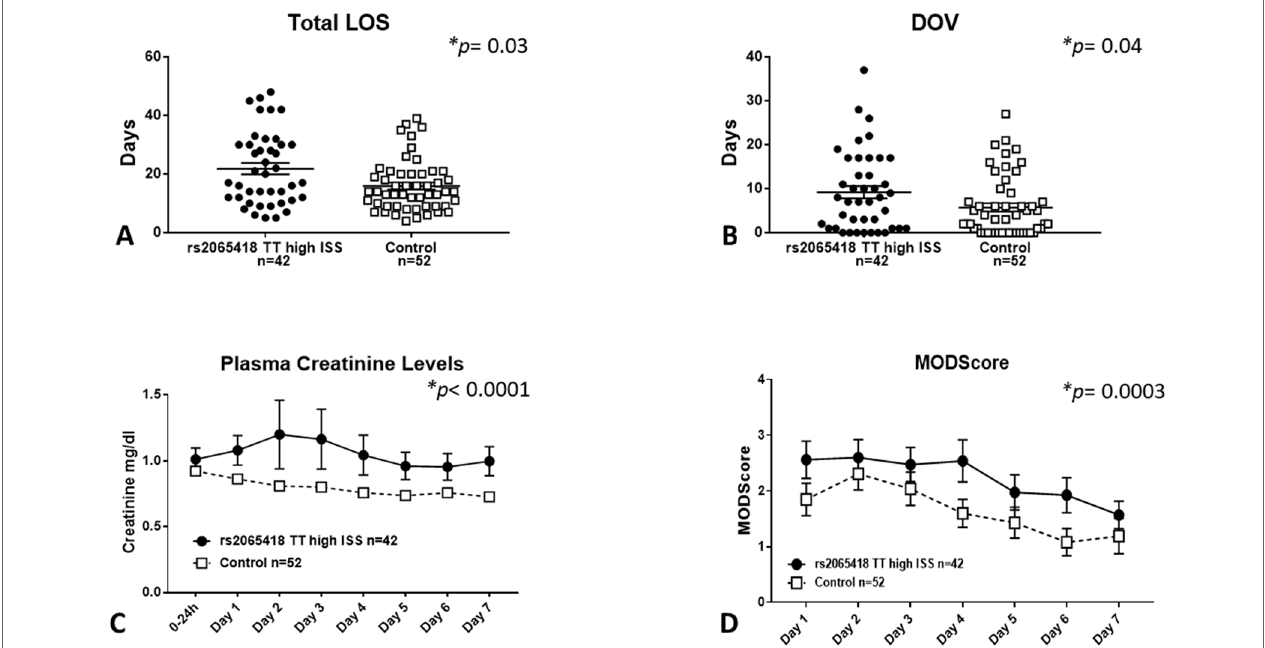
FIgUre 2 | Severely injured rs2065418 TT patients exhibit worse clinical outcomes vs. control. High-severity rs2065418 TT patients ( n = 42) and control rs2065418 TG/GG patients ( n = 52) were assessed for clinical outcomes as described in the Materials and Methods . High-ISS rs2065418 TT patients exhibited longer total LOS ( p = 0.03) (A) longer DOV ( p = 0.04) (B) elevated plasma creatinine levels ( p 0.0001) (c) , and higher Marshall MODScore over 7 days ( p = 0.0003) (D) compared to the control group of high-ISS rs2065418 TG/GG patients. Total LOS and DOV were not normally distributed and therefore were tested by Mann– Whitney U